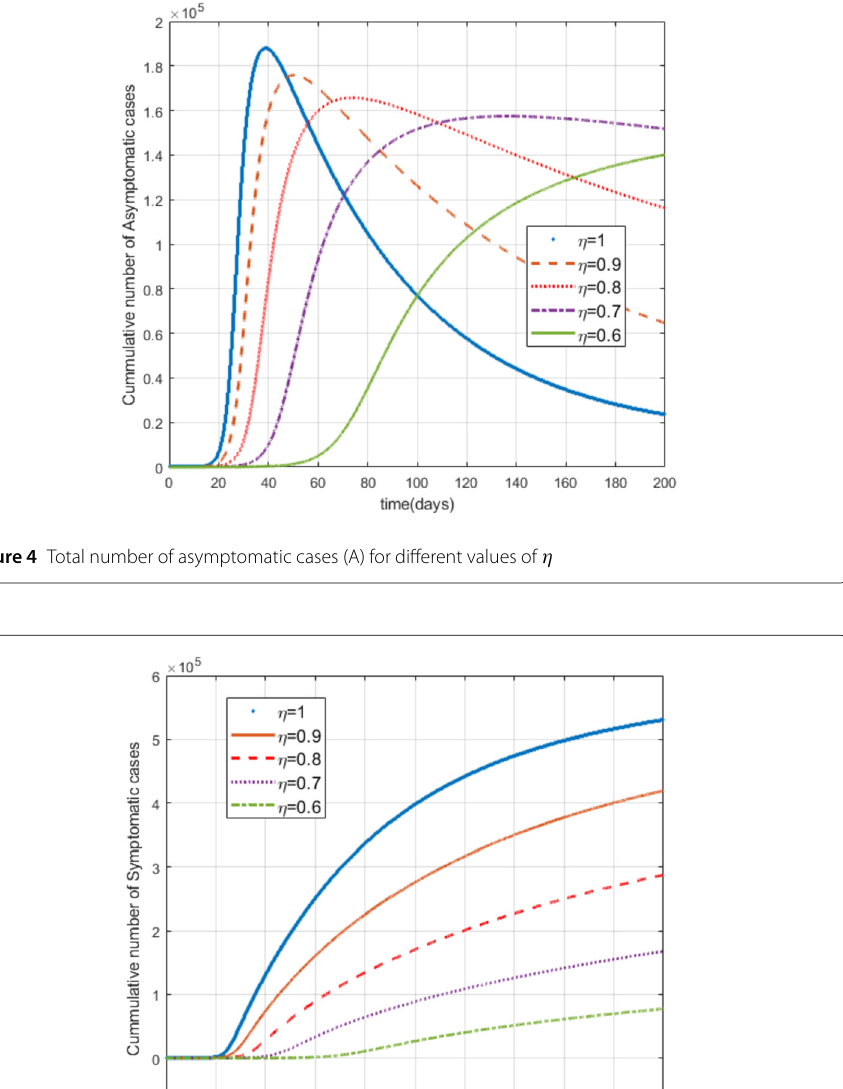
the integer order are the same and the solution of the fractional order tends to the EEP over a longer time. From Figs. 2–6 it seems that as the fractional derivative gets smaller and smaller, the time it requires to approach to the EEP gets longer and longer. That is, when the derivative order is reduced from 1, the memory effect of the dynamic system increases, and, consequently, the infection in each of the compartments increases slowly for a long time. Hence the fractional derivative order η affects the dynamics of infection of model (3b) at least in this work. The peak period of the compartments E, A, R, and I is prolonged, and the number of cases at the peak is reduced as η reduces from 1 to zero (see Figs.